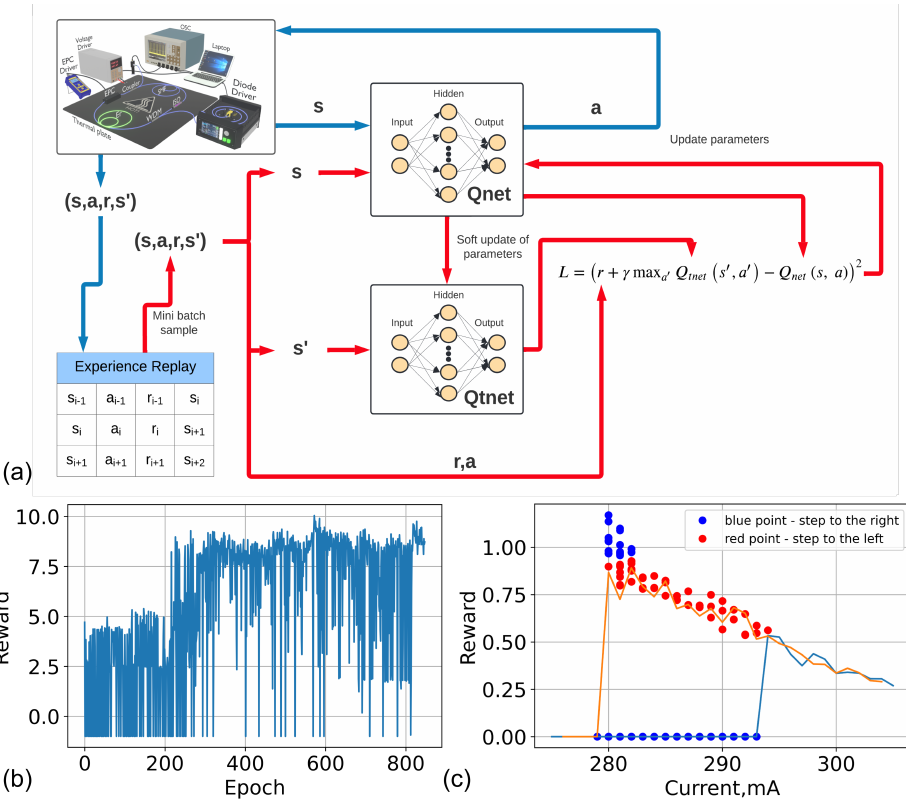
Figure 4. ( a ) Principle scheme of the DDQN algorithm. ( b ) Learning curve of the DDQN algorithm. ( c ) Laser current adjustment by the DDQN algorithm after the training stage. Blue and orange lines correspond to the calculated reward by consequently increasing the current up to 305 mA and decreasing it back down to initial